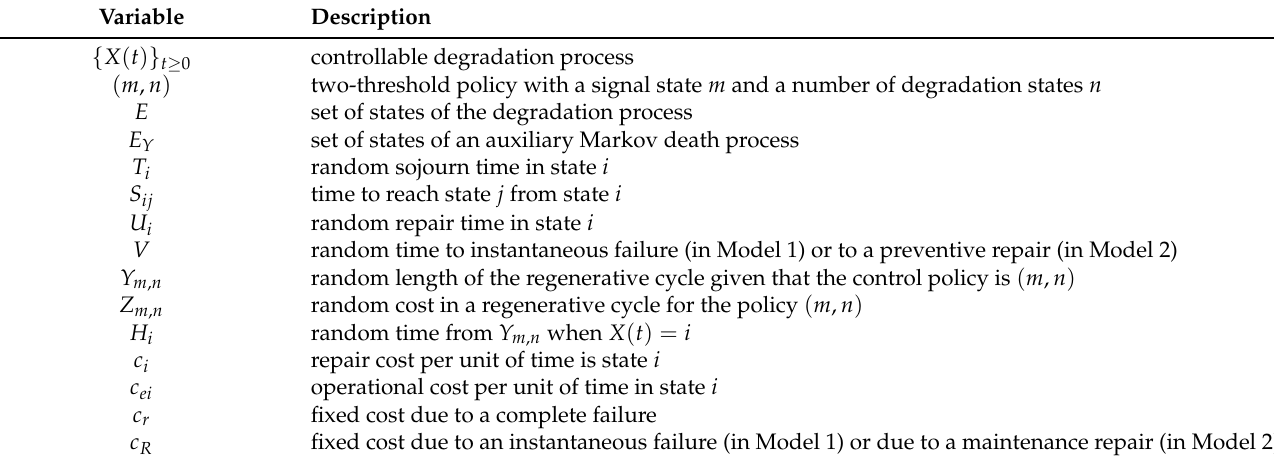
Table 1. List of the main notations used in the